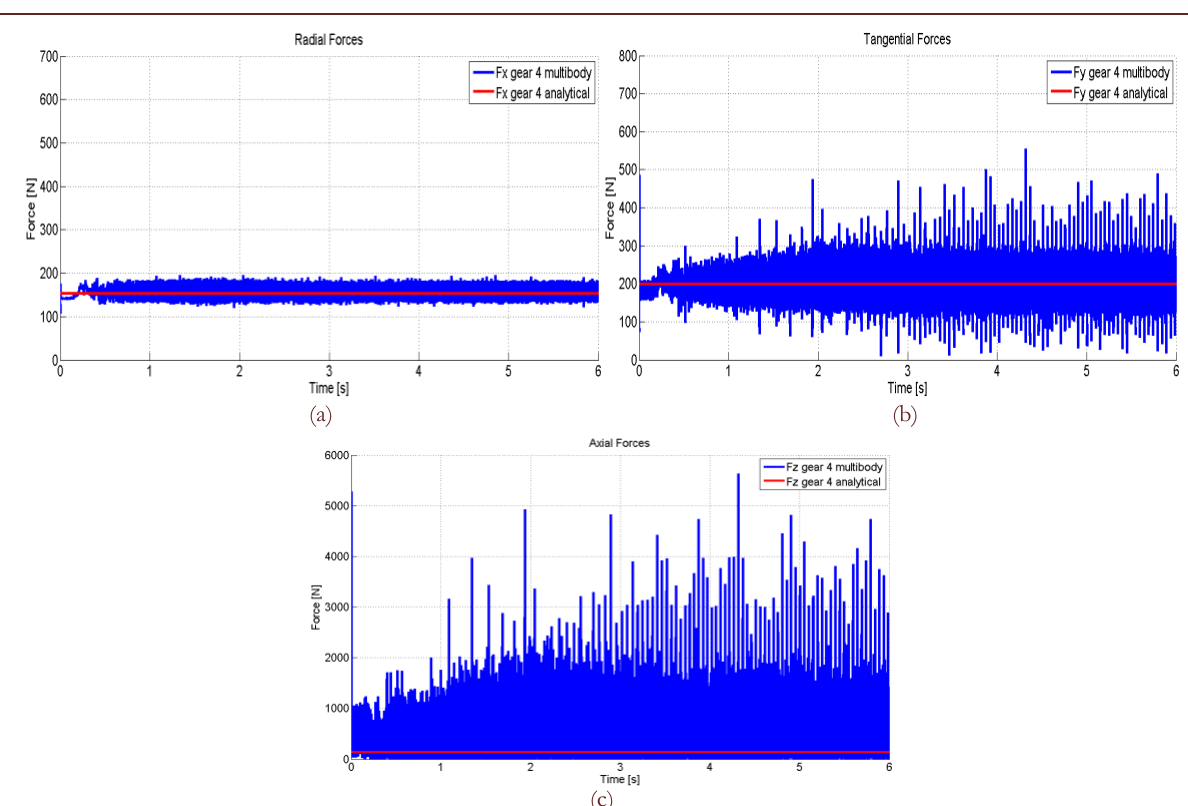
Figure 5: Forces of the Rigid-Flexible simulation of Gear 4, (a) contact force in x direction (radial force), (b) contact force in y direction (tangential force), (c) contact force in z direction (axial force).